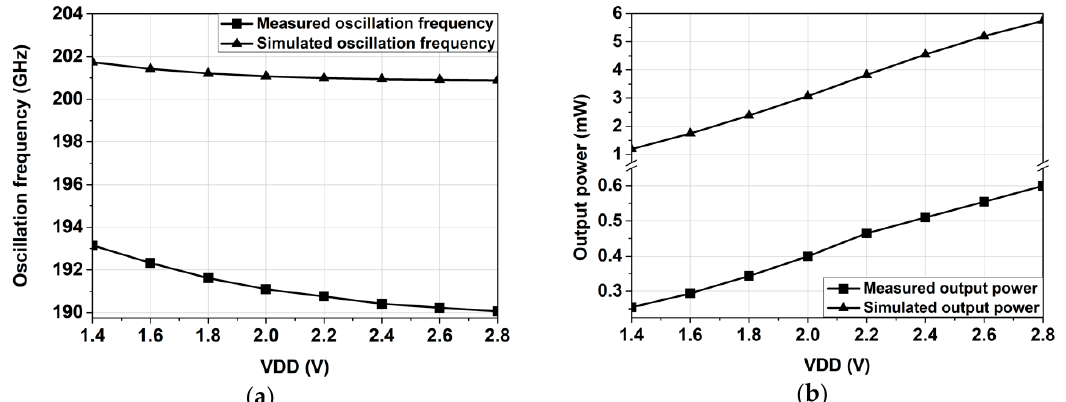
Figure 9. ( a ) Measured oscillation frequency and simulated oscillation frequency; ( b ) measured output power and simulated output power of the proposed oscillator with the change of voltage supply V DD .